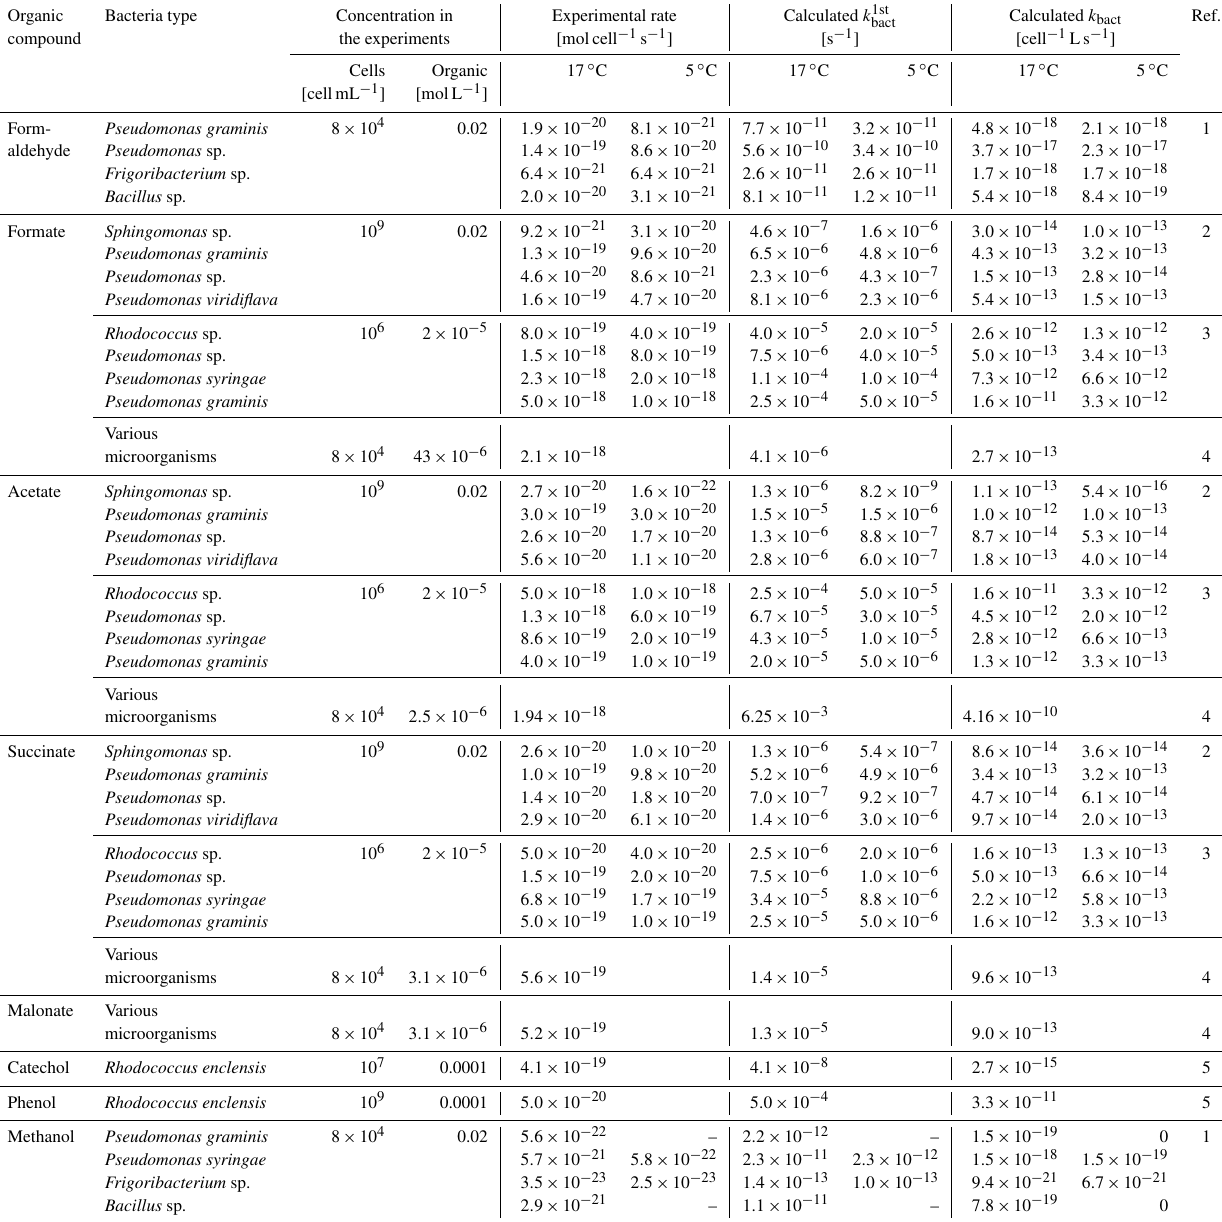
Table 2. Summary of biodegradation rates from the literature and calculated rate constants ( k bact ) for the consumption of small organic species by bacteria isolated from cloud